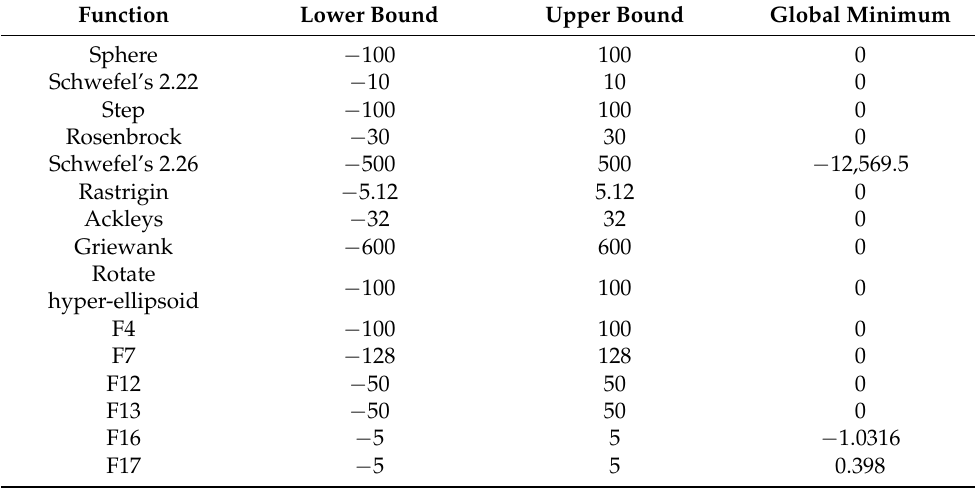
Table 2. Mathematical functions